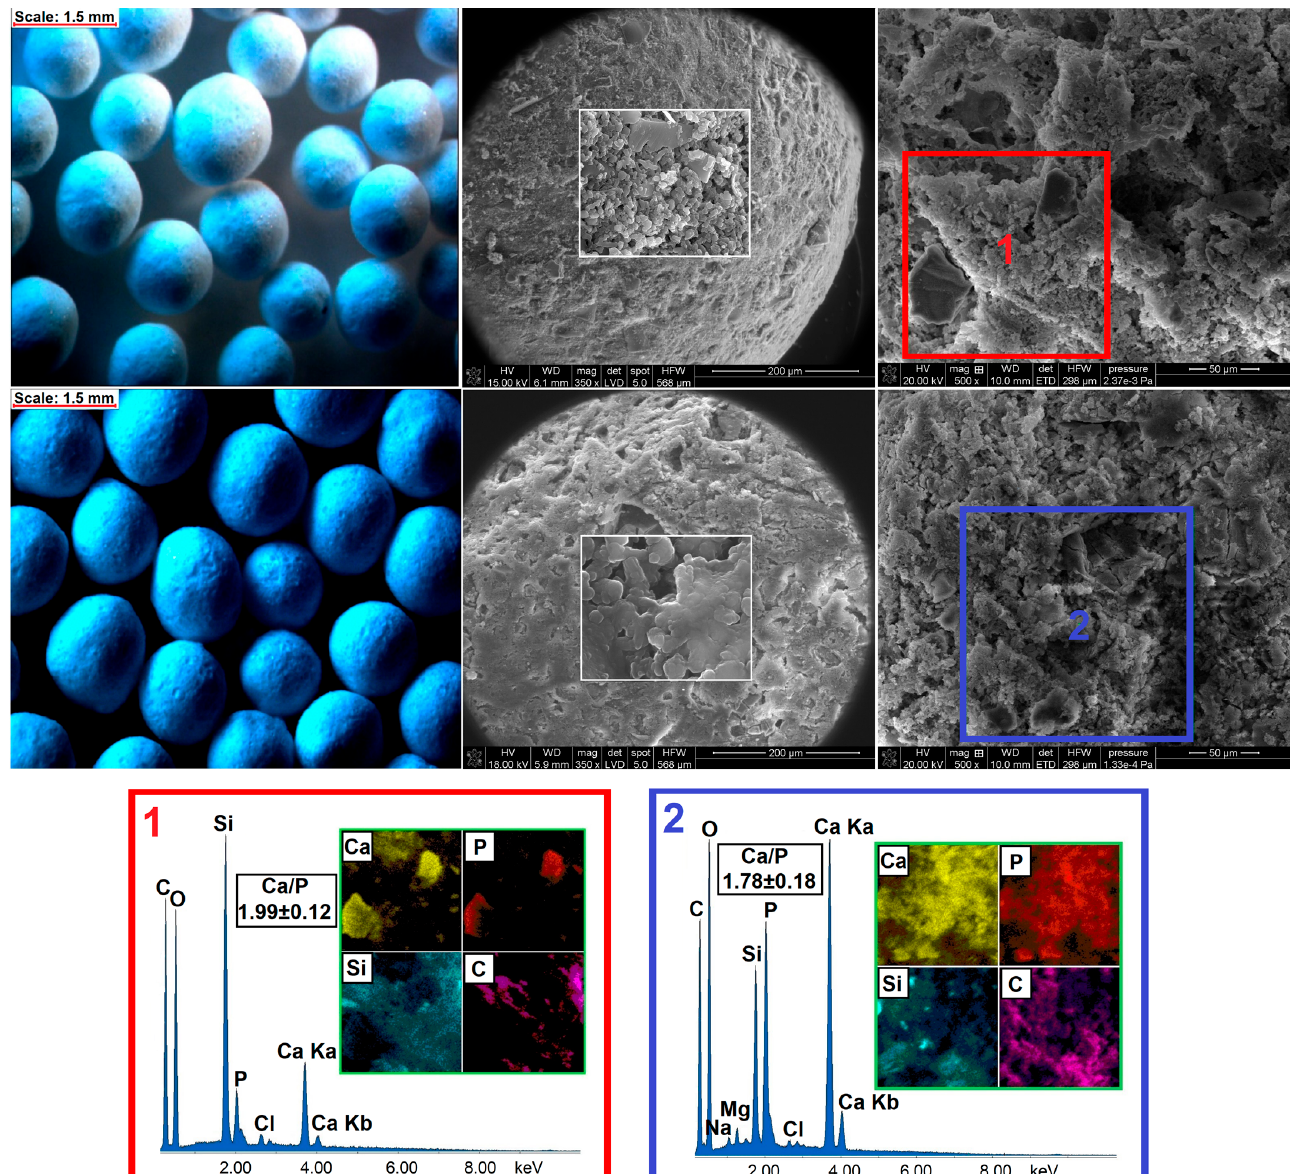
Figure 7. The stereoscopic images and SEM micrographs of pellets before (upper row) and after (lower row) 28 days of incubation in SBF with corresponding EDX mapping.